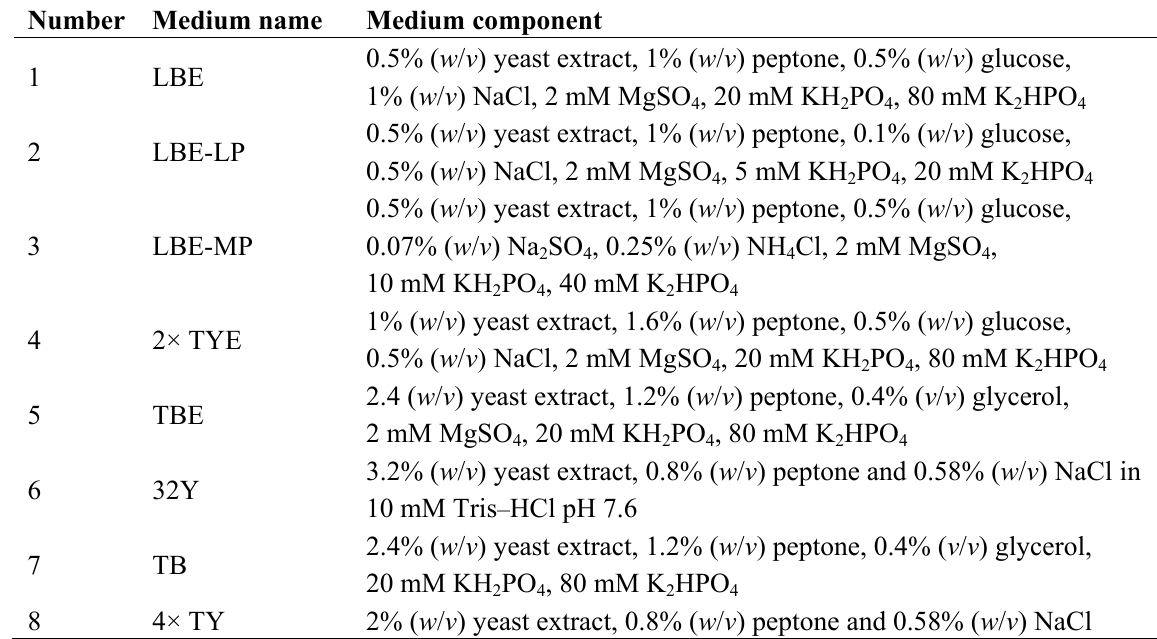
Table 1. Compositions of the culture